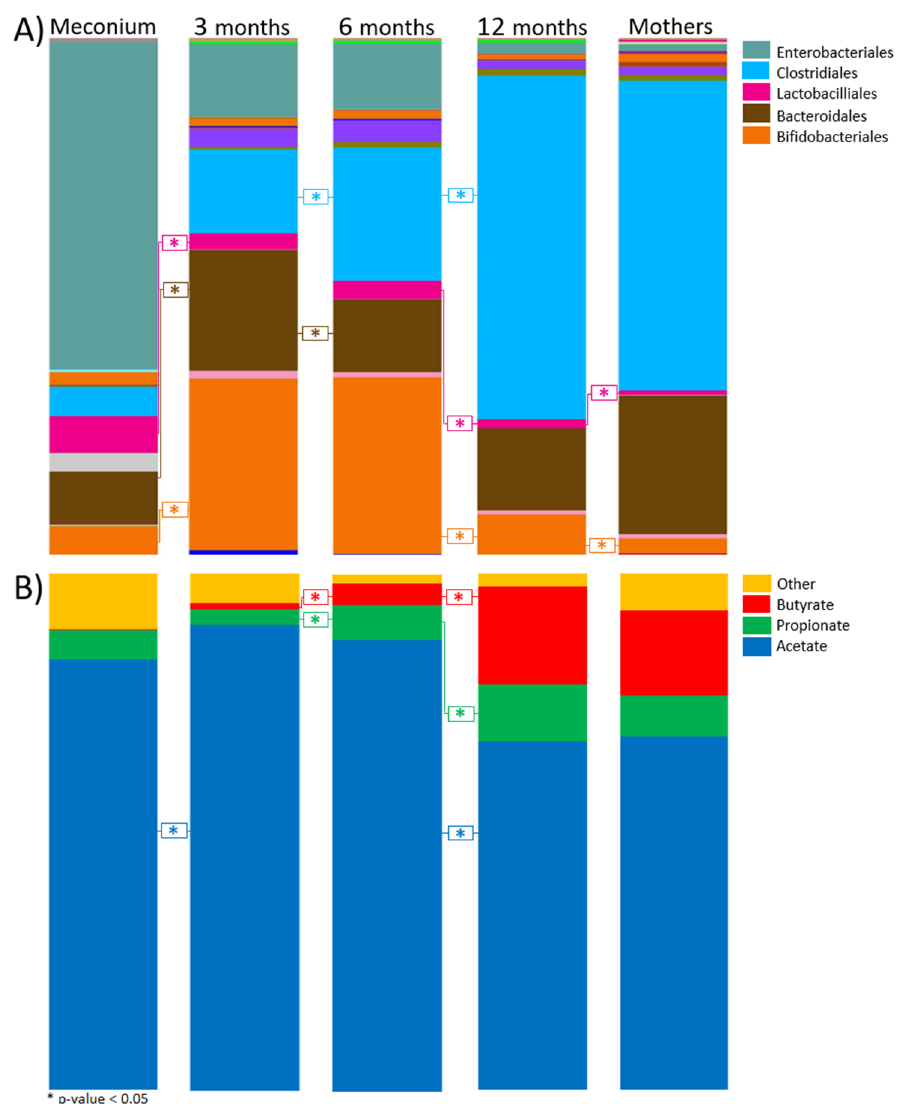
Figure 2. Taxonomic and short-chain fatty acid (SCFA) composition. The bar chart shows the relative abundance (%) of bacterial orders acquired from sequencing processed by the QIIME pipeline ( A ) and SCFAs composition ( B ) for the respective age groups. The dominant orders of bacteria and SCFAs in their respective colors are displayed on the top right. The asterisks (*) represent a p -value < 0.05, determined by Kruskal–Wallis–Dunn’s test, FDR correct by the Benjamini–Hochberg method. The exact p-values are shown Supplementary Tables S1 and S2. SCFAs illustrated represent percent based on average total SCFAs detected. SCFAs included in the “other” group are isobutyrate, isovalerate, and valerate.